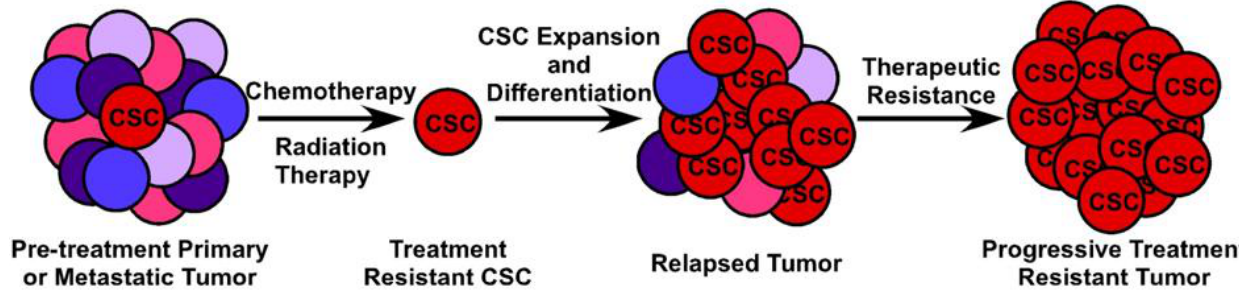
Figure 4. Clinical implications of the CSC model. Systemic chemotherapy and